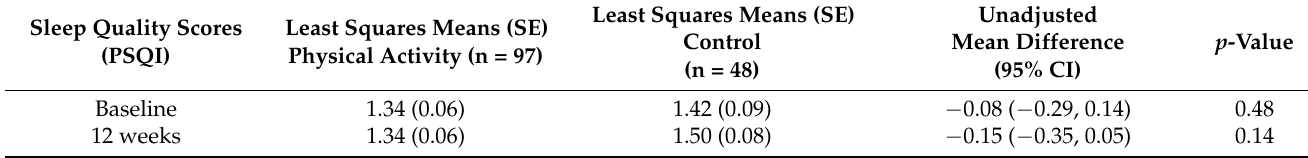
Table A5. Disturbances